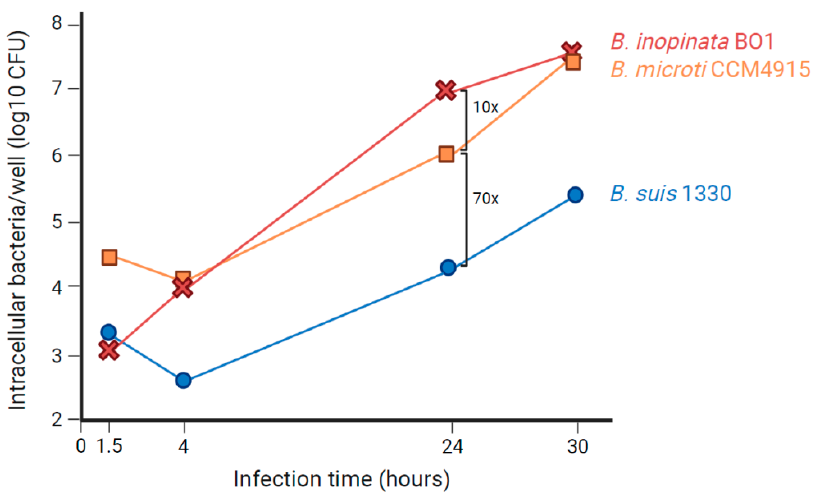
Figure 6. Intracellular replication profiles of B. inopinata BO1 and B. microti CCM4915 in J774 murine macrophage-like cells. Profiles of the novel species are shown in comparison to the intracellular growth curve of the classical species B. suis bv. 1 strain 1330. Fold-change differences in the number of viable intracellular bacteria at 24 h are indicated. Modified from [14] . Created with BioRender.com.